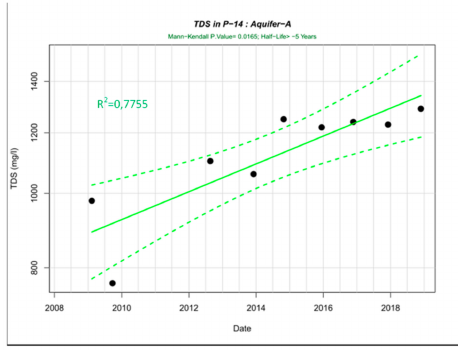
Figure 7. TDS trends in analyzed boreholes [ground water spatiotemporal data analysis tool (GWSDAT